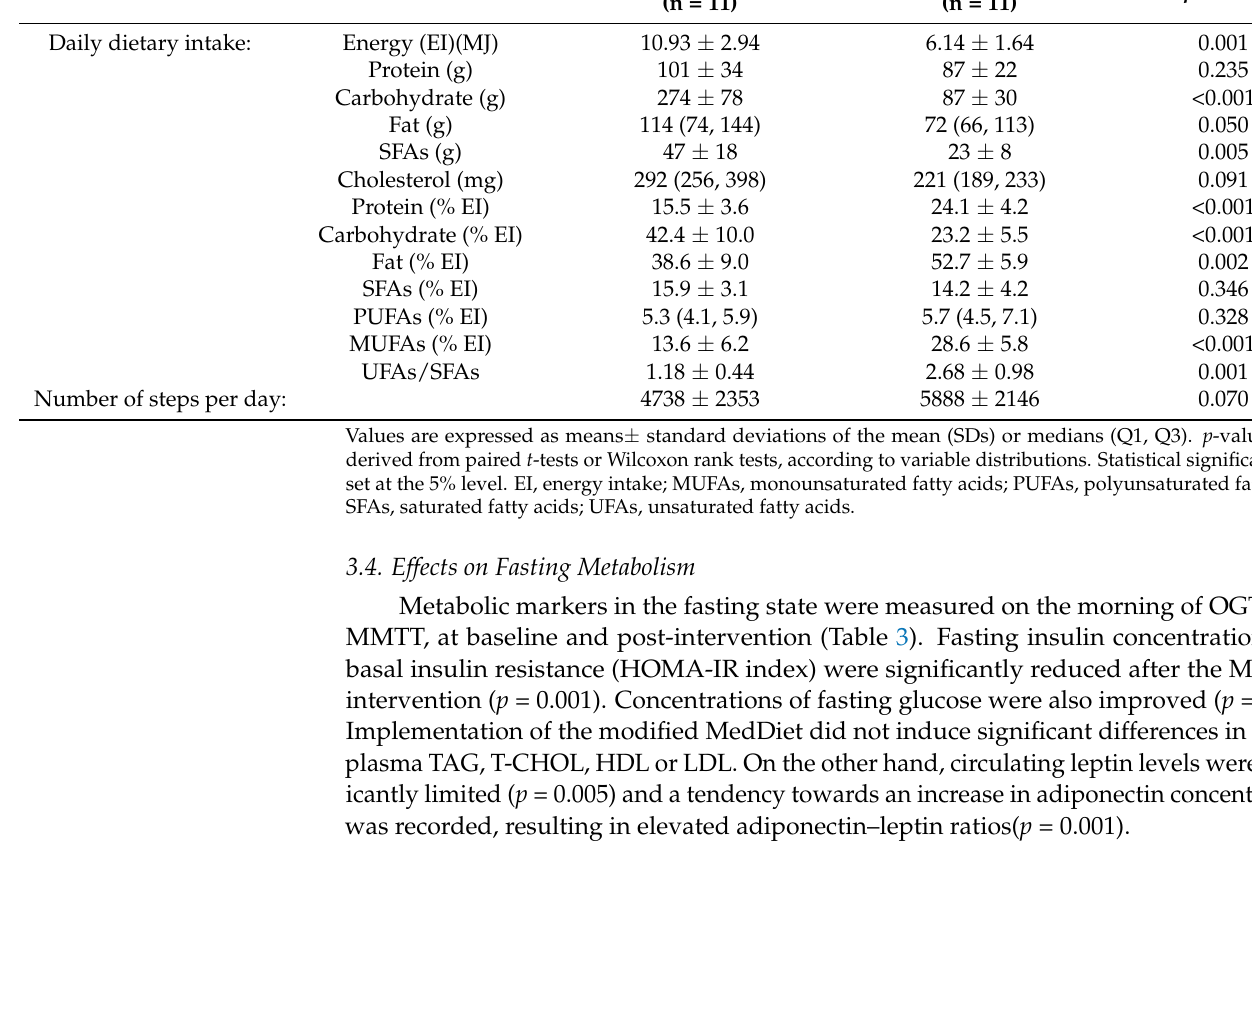
Table 2. Dietary intake and physical activity prior to and during the weight-loss intervention. Indices